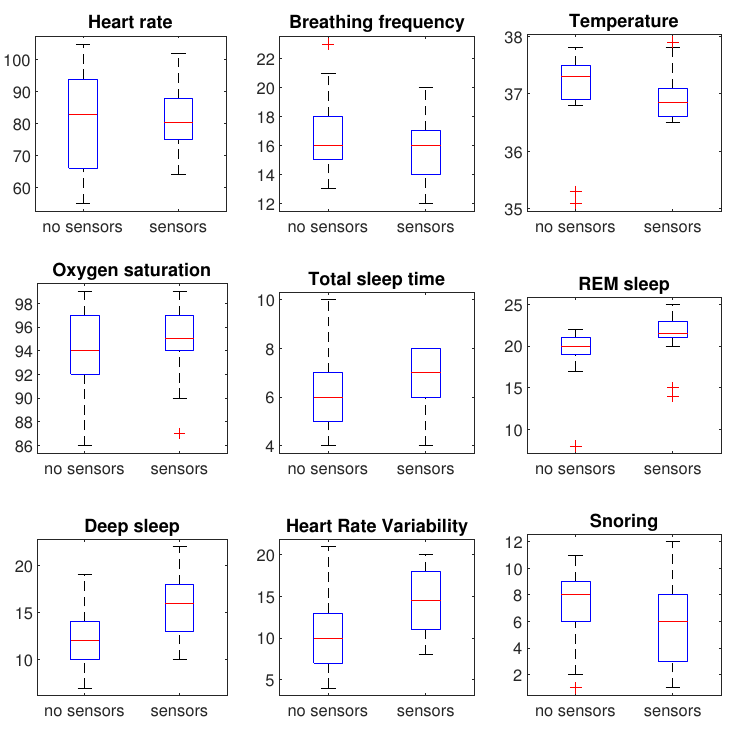
Figure 19. Behavior of vital signs in people with the sensor network and without the sensor network. The overall sleep score on a smartwatch is a sum of the individual scores for sleep duration, sleep quality, and recovery, with a maximum total score of 100. Most people